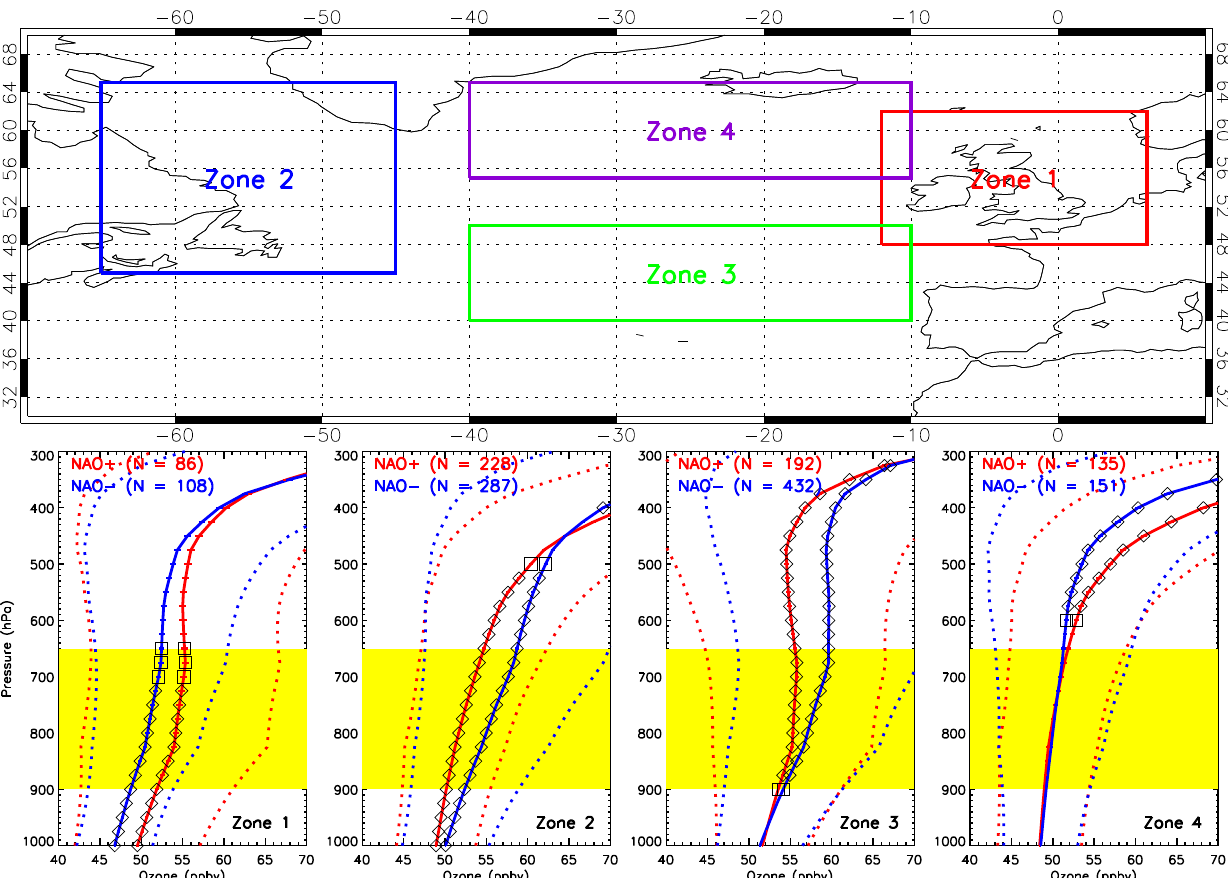
Figure 5. Tropospheric Emission Spectrometer (TES) ozone profiles, averaged over four regions (Zone 1: 48–62 ◦ N, 12 ◦ W–6 ◦ E; Zone 2: 45–65 ◦ N, 45–65 ◦ W; Zone 3: 40–50 ◦ N, 10–40 ◦ W; Zone 4: 55–65 ◦ N, 10–40 ◦ W,), between 2005 and 2011, sampled under the winter- time (NDJF) NAO positive (red line) and negative (blue line) phases. Horizontal lines show the satellite uncertainty range, the yellow box highlights the region of peak TES sensitivity to lower-tropospheric ozone and the dotted lines show the profile averages are plus or minus their respective standard deviations. Squares and diamonds show where the ozone profiles sampled under each NAO phase are significantly different from each other at the 90 and 95% confidence levels based on the